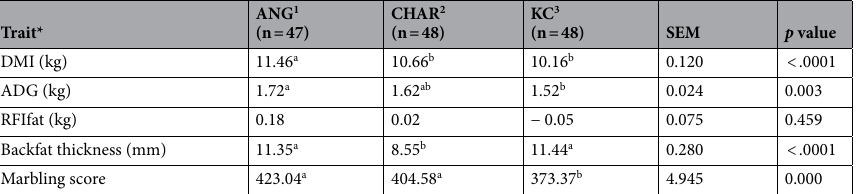
Table 1. Effects of different breeds on performance traits of beef cattle. *DMI = dry matter intake; ADG = average daily gain; RFIfat = residual feed intake adjusted for backfat thickness. 1 Angus breed; 2 Charolais breed; 3 Kinsella Composite breed. Means in the same row with different superscripts (a, b) indicate significance ( p <